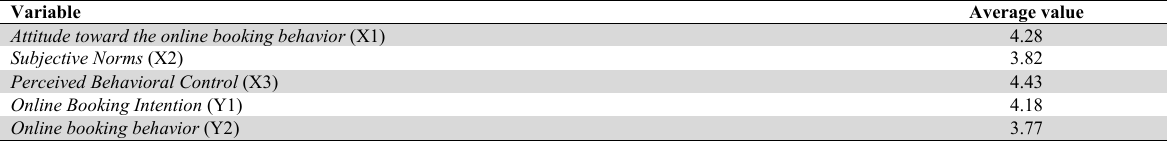
Results of Descriptive Statistical Analysis Variable